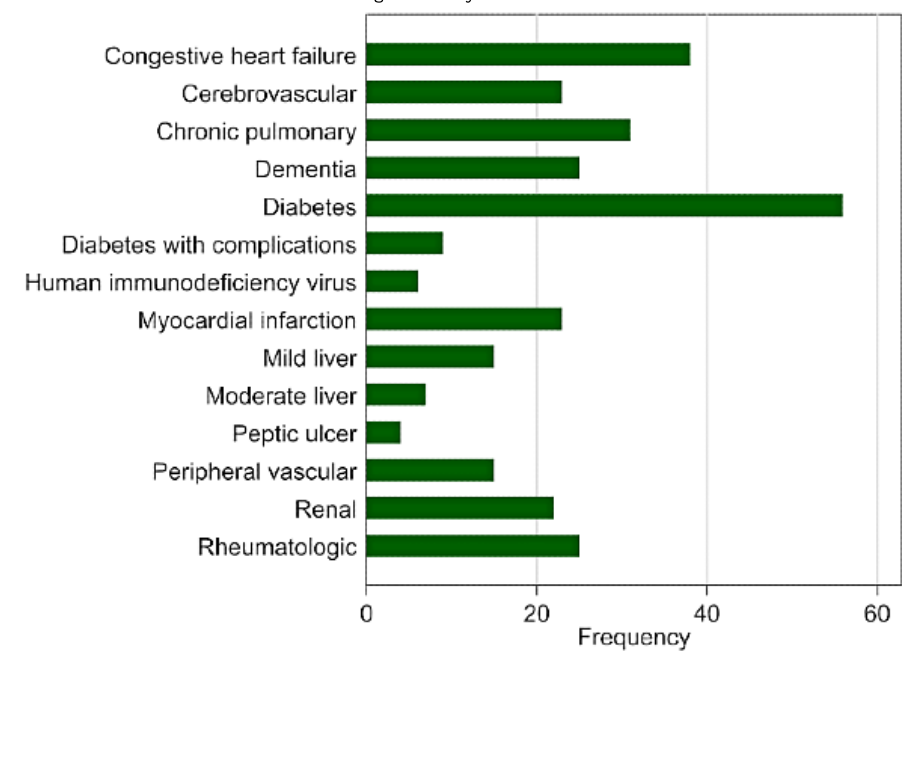
Figure 2. Distribution of electronic medical record data–based algorithms by Charlson disease